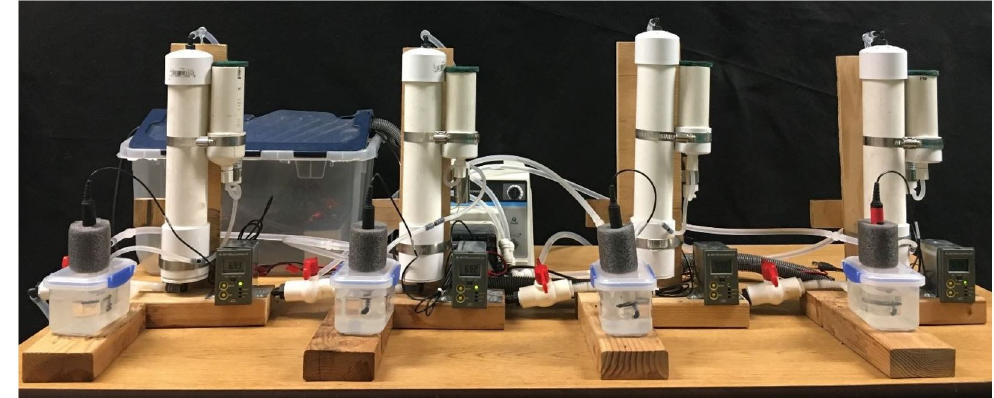
Fig 3. System for measuring urea hydrolysis. Recirculating columns filled with perlite were used to measure concentrations of urea and ammonium over 30 days.